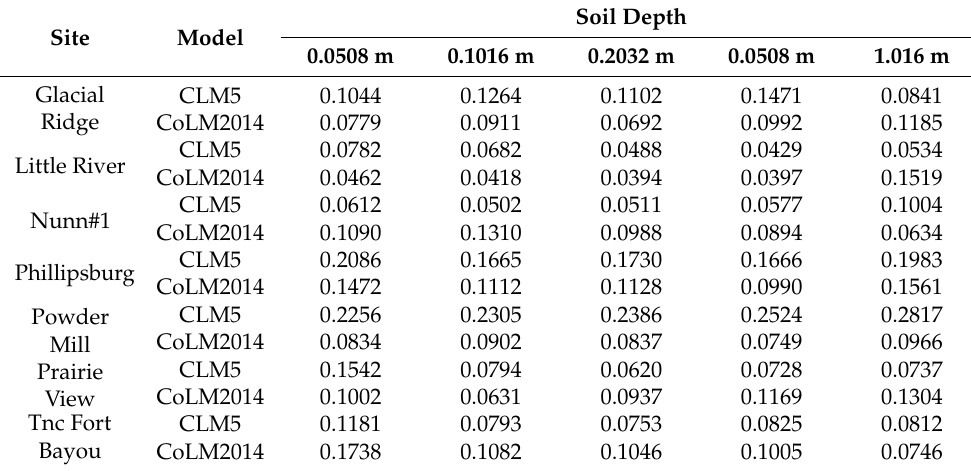
Table 4. RMSE of the simulated soil moisture at selected SCAN